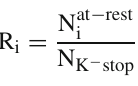
respond to the systematic errors. The gray line distributions represent the global fitting functions, the coloured distributions represent the dif- ferent contributing processes according to the colour code reported in the legend and the widths correspond to the statistical